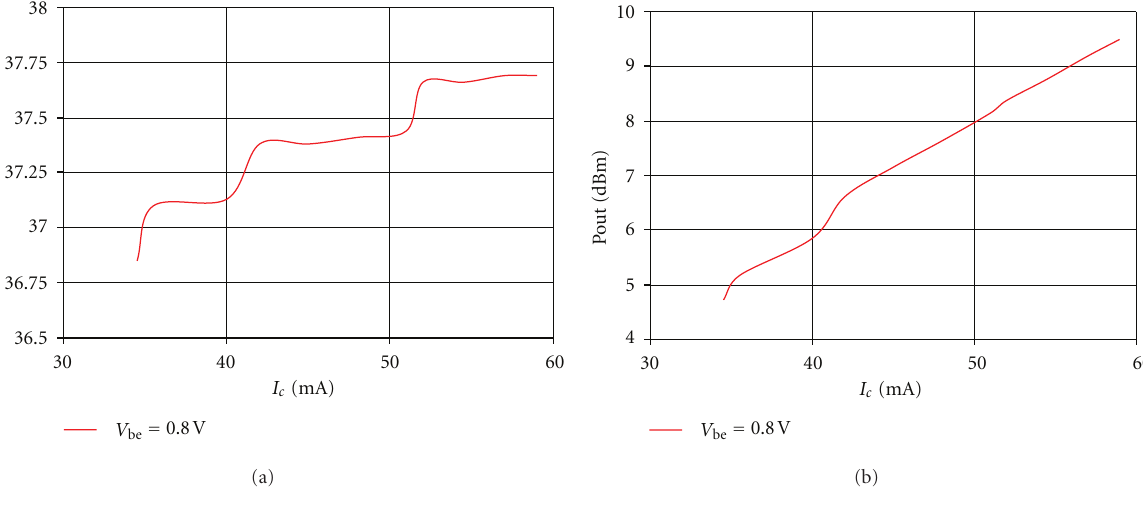
voltage equal to 0.8 0